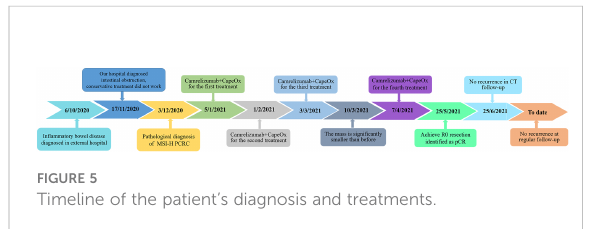
FIGURE 5 Timeline of the patient ’ s diagnosis and